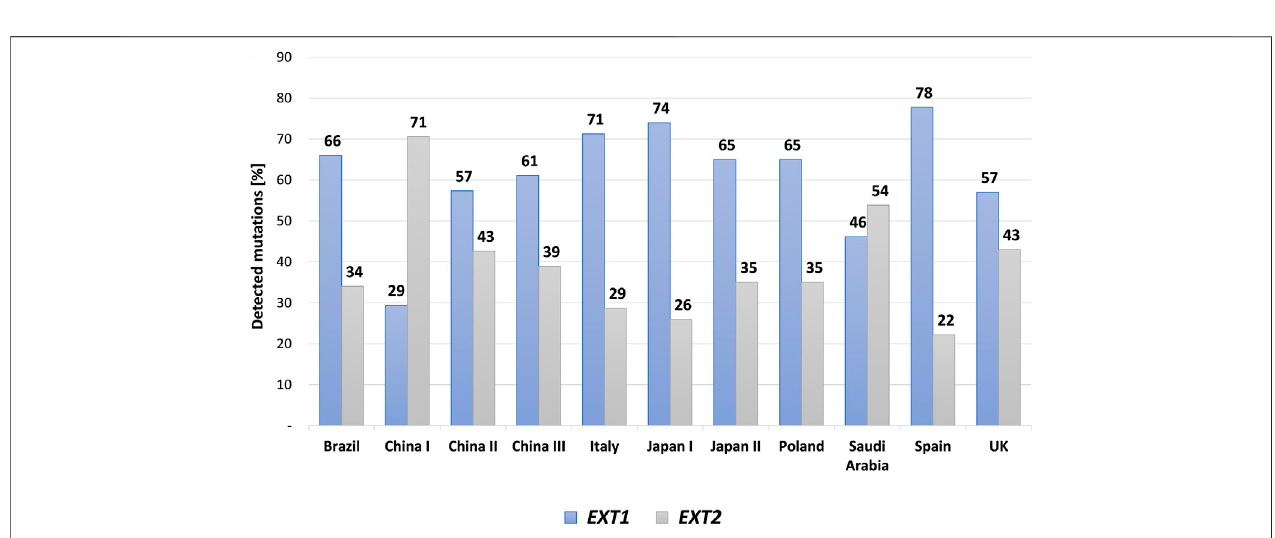
FIGURE4| Abargraphshowingmutationaldiscrepanciesinthe EXT1 and EXT2 amongdifferentcohortsofpatientsaffectedwithhereditarymultipleexostoses(HMEs)and reported in themedicalliterature. Thefollowingcohortswere included: Brazilian,Chinese, Italian,Japanese,Polish, SaudiArabic, SpanishandUnited Kingdom(UK) populations.